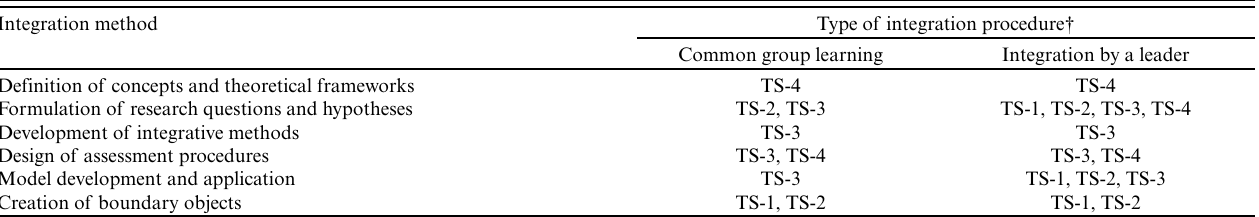
Table 3. Overview of the combinations of integration methods and procedures applied within the four thematic syntheses